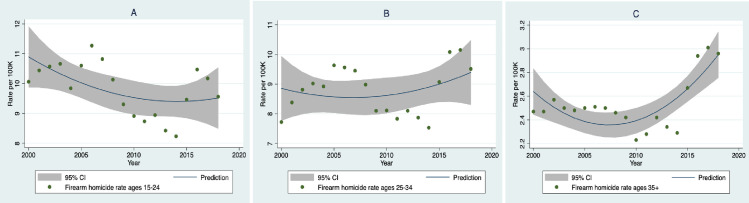
Plots of best fitting trends between study year and firearm homicides for three age groups.